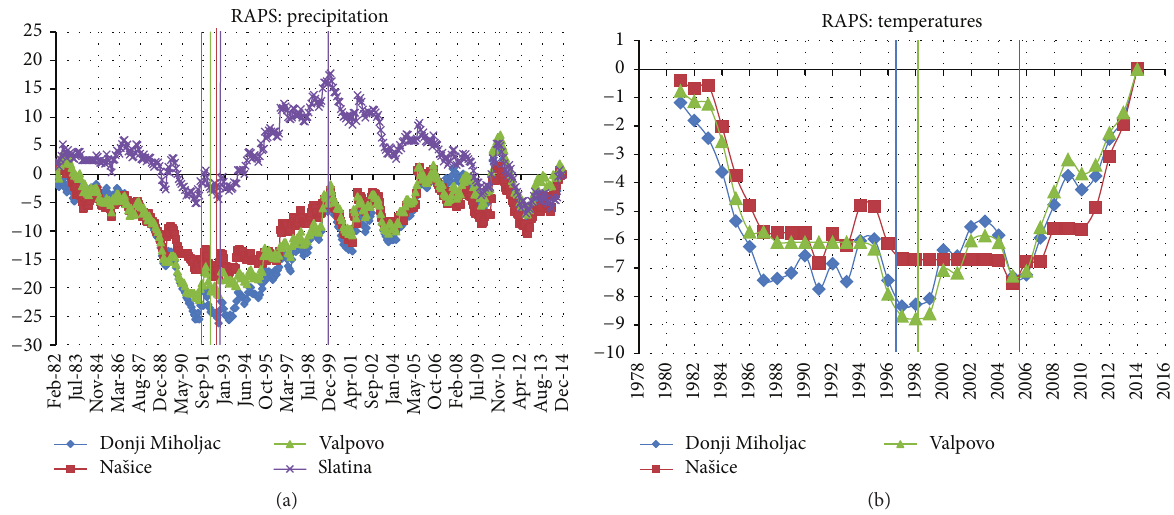
Figure 7: (a) RAPS of monthly precipitation data and (b) RAPS of mean annual air temperature data.